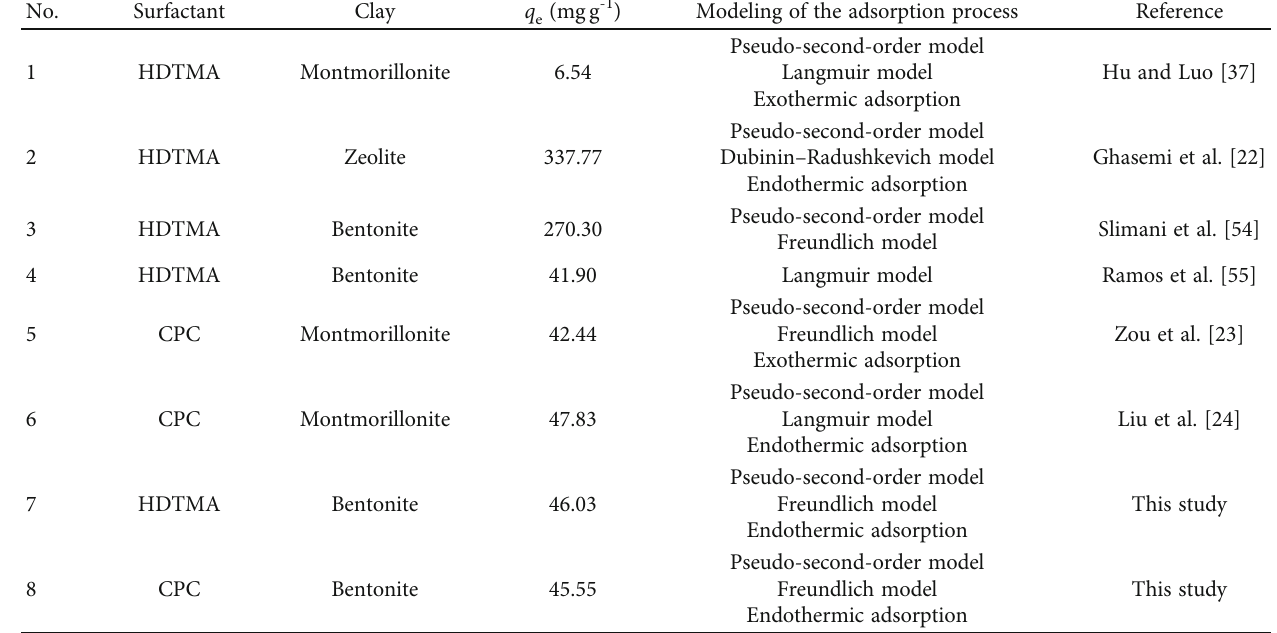
Table 1: Adsorption capacity of Cr(VI) by modi fi ed clays with surfactants.